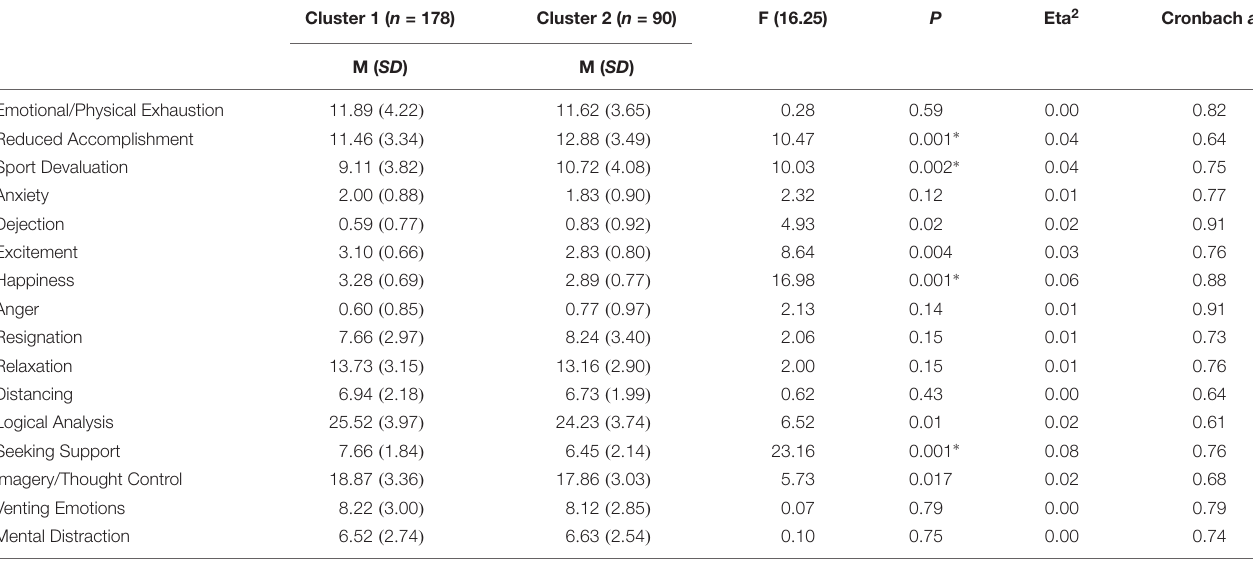
TABLE 2 | Cluster Differences on Burnout, Coping, and